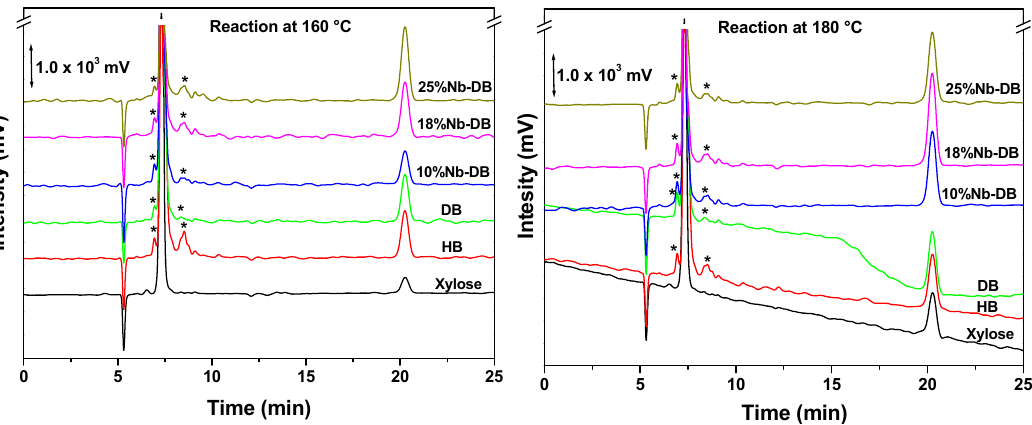
Figure 7. HPLC-RID chromatograms generated in the catalytic reactions (* refers to by-products).